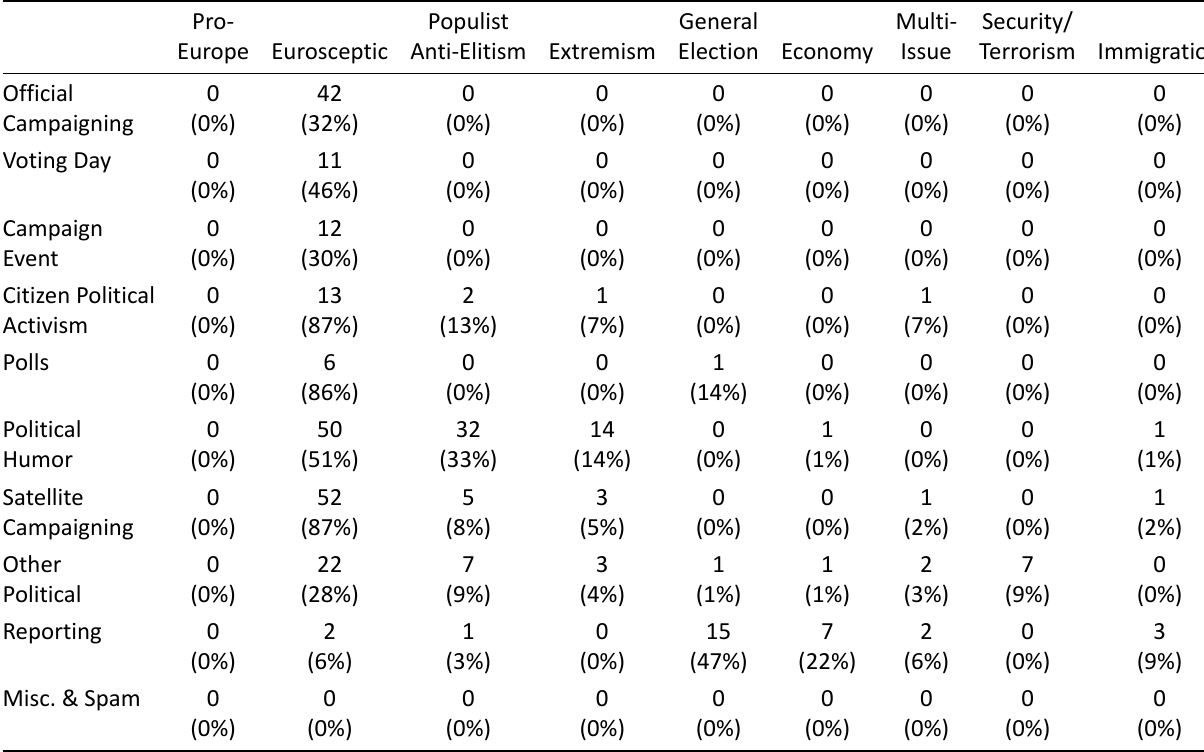
Table 6. Cross tabulations of visuals modes and themes in ‘Exit’